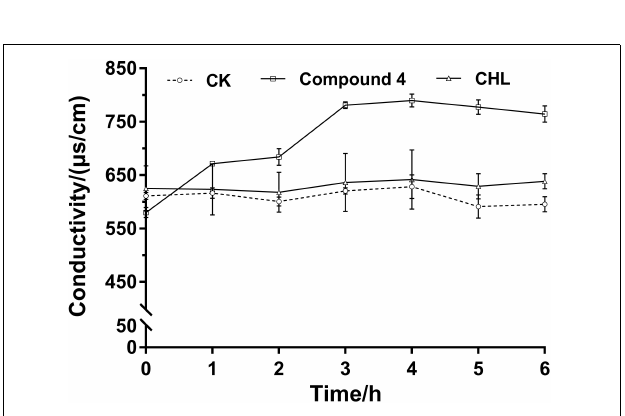
FIGURE 6 | SEM of RS-2 (A) untreated cells and (B) after treatment with compound 4 at EC50 value for 6 h.